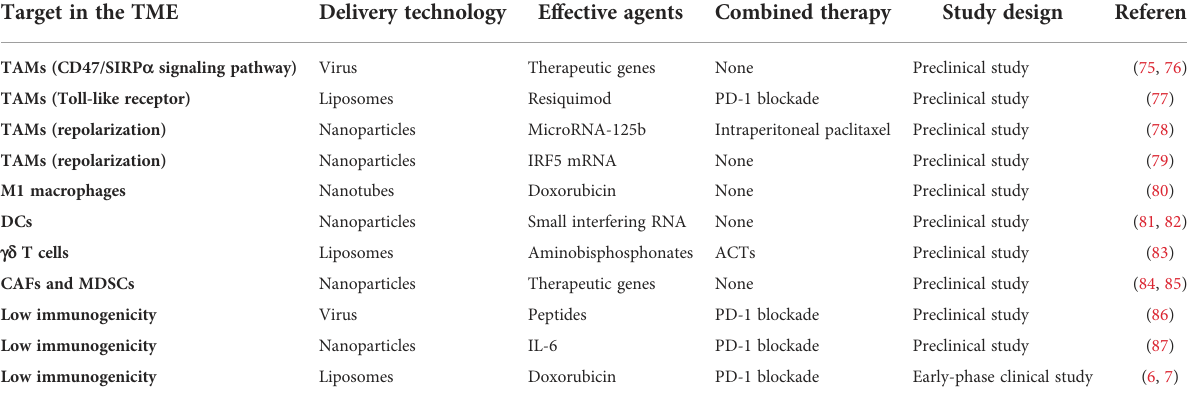
TABLE 2 Drug delivery systems (DDSs) currently developed to target the tumor microenvironment (TME) in ovarian cancer. Target in the